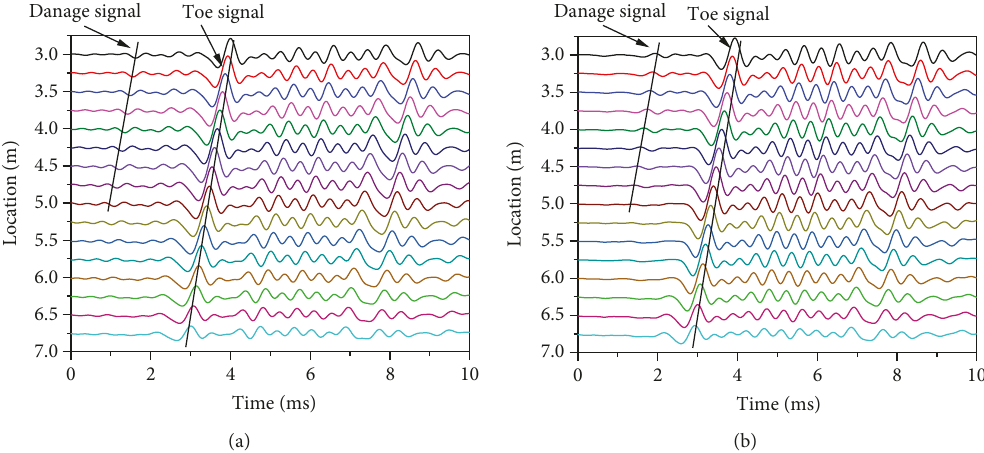
Figure 20: Upward velocity data. (a) Velocity data at A